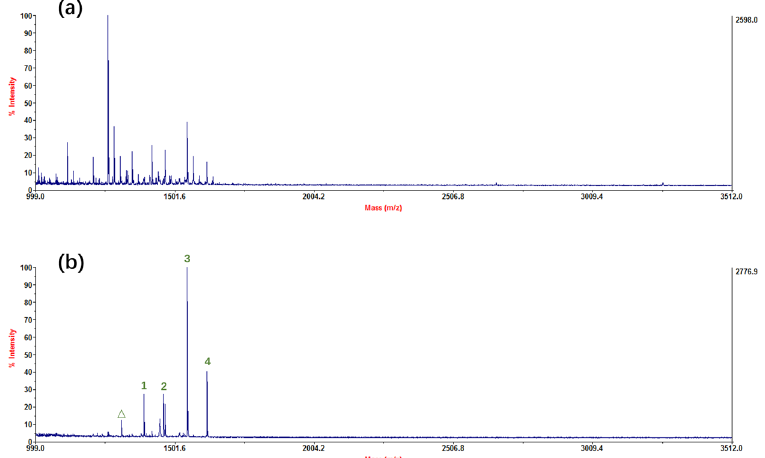
Figure 5. MALDI-TOF mass spectra for the phosphopeptide enrichment from human serum: ( a ) before enrichment, and ( b ) after enrichment, where phosphopeptides were marked with Arabic Numerals in green, and Δ indicates the losses of phosphoric